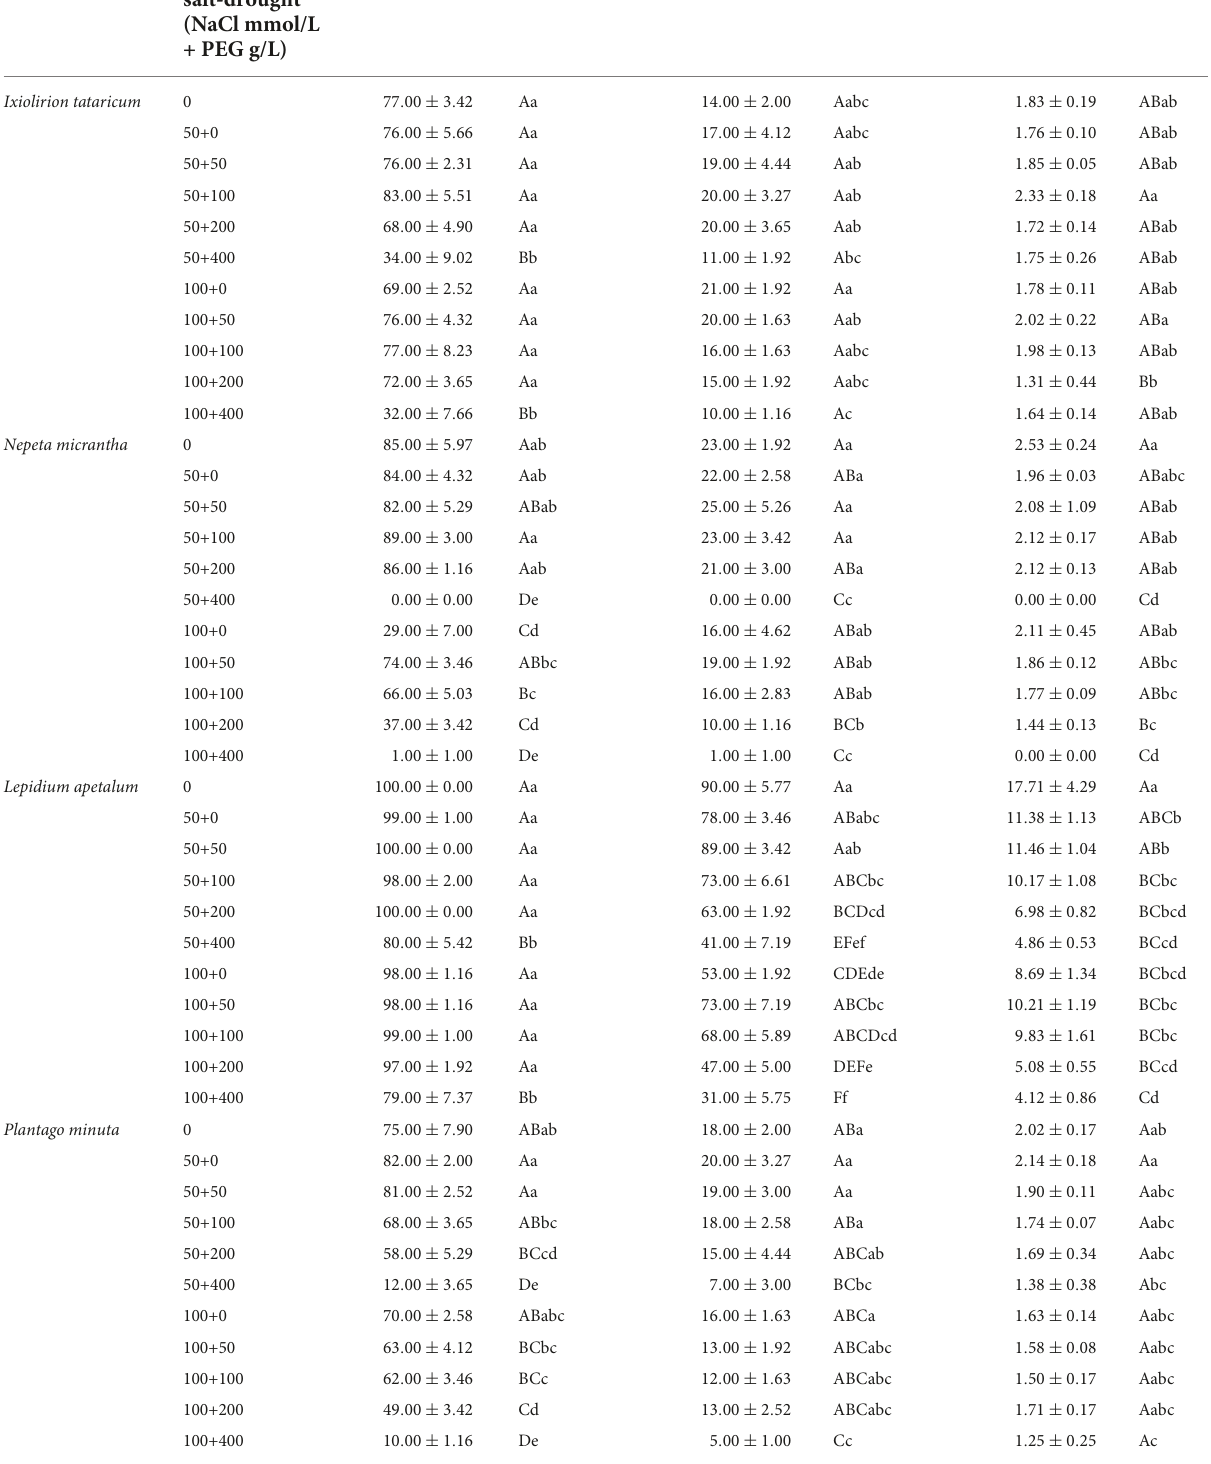
TABLE 3 Effects of coupled salt-drought on germination percentage, germination potential, and germination index. Germination percentage (%) Germination potential Species Coupled salt-drought (NaCl mmol/L + PEG g/L)